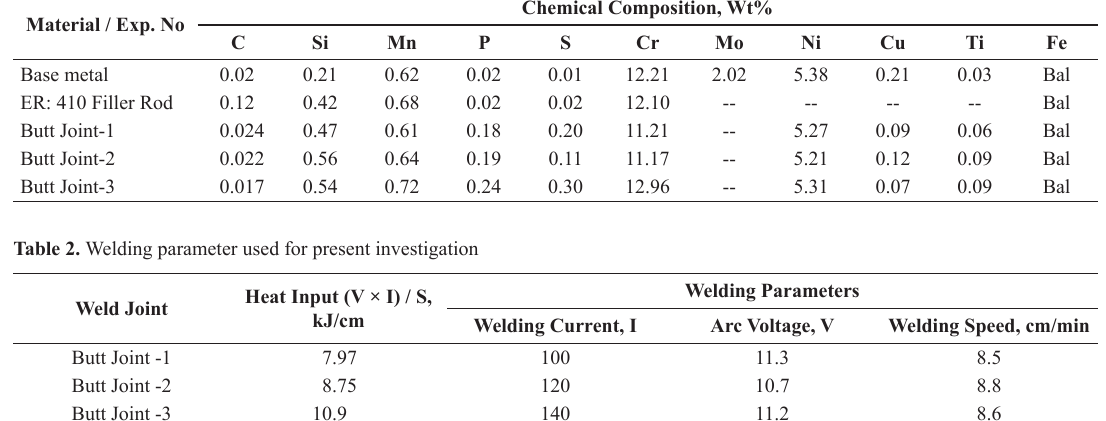
Table 1. Chemical composition of base metal, filler wire and multi-pass GTA weld deposits Material / Exp. No